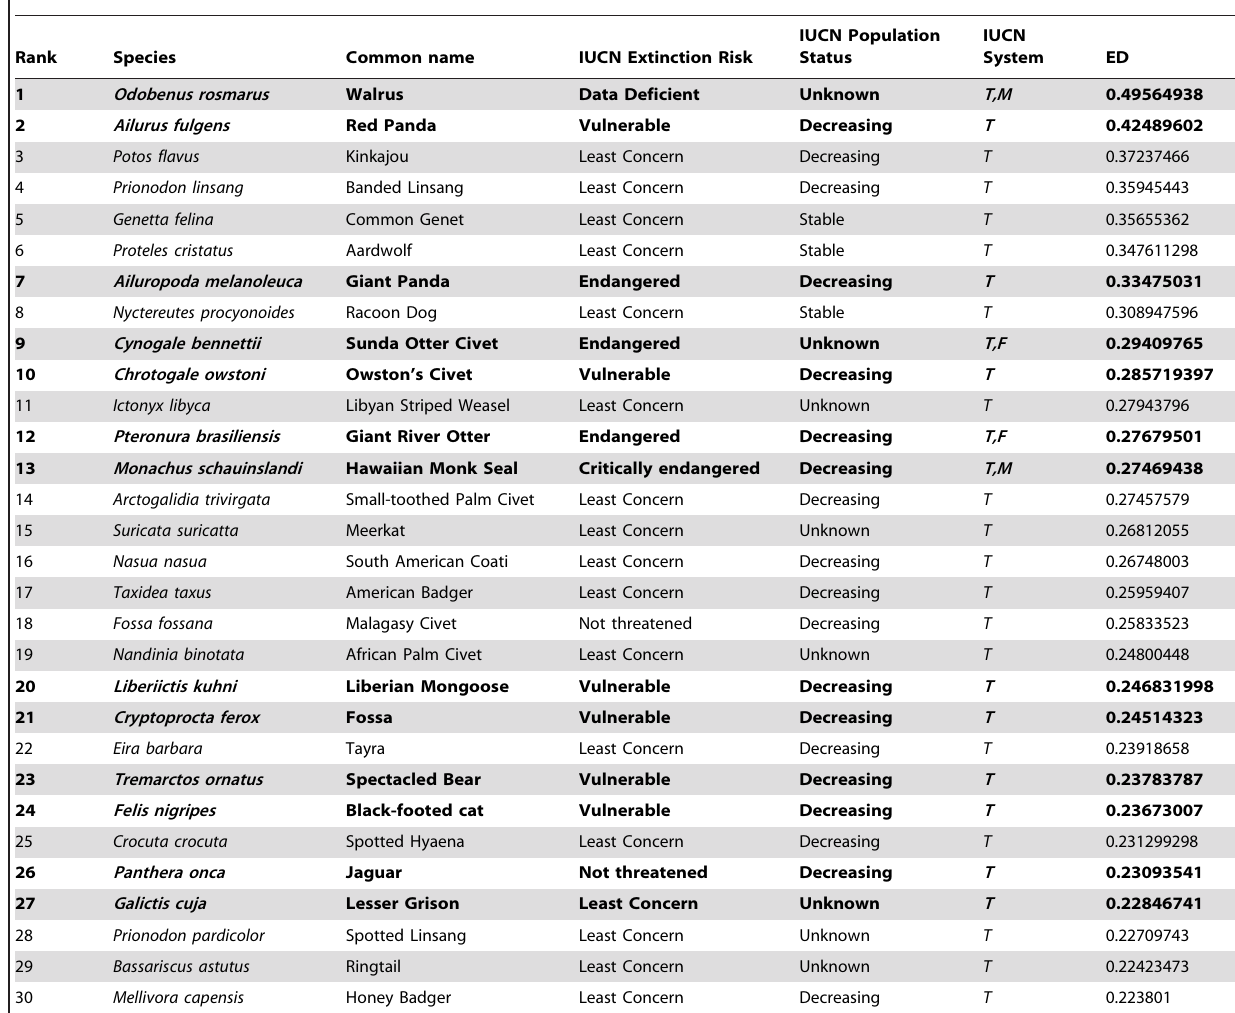
Table 5. Top 30 most evolutionarily distinct (ED) species for